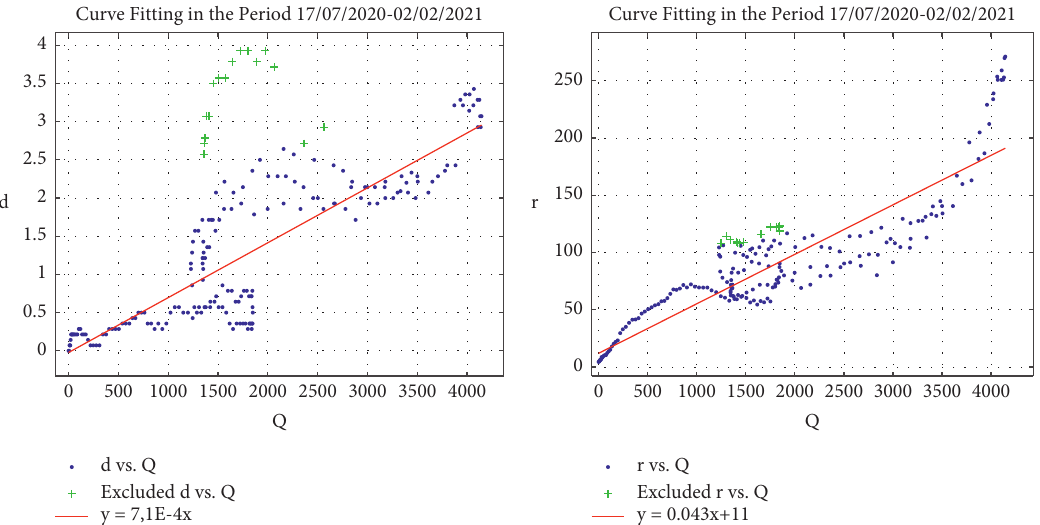
Figure 7: Linear regression in the period from 17/07/2020 to 02/02/2021 to estimate the parameters α